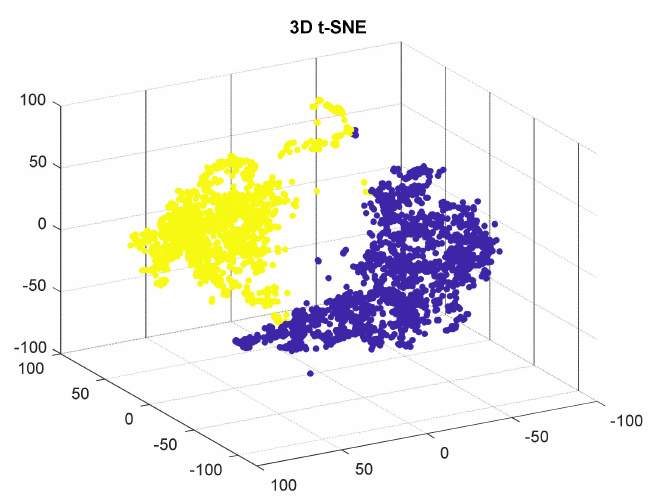
Figure 8. 3D visualization of some corrugated samples in cyan, and noncorrugated samples in red, after using